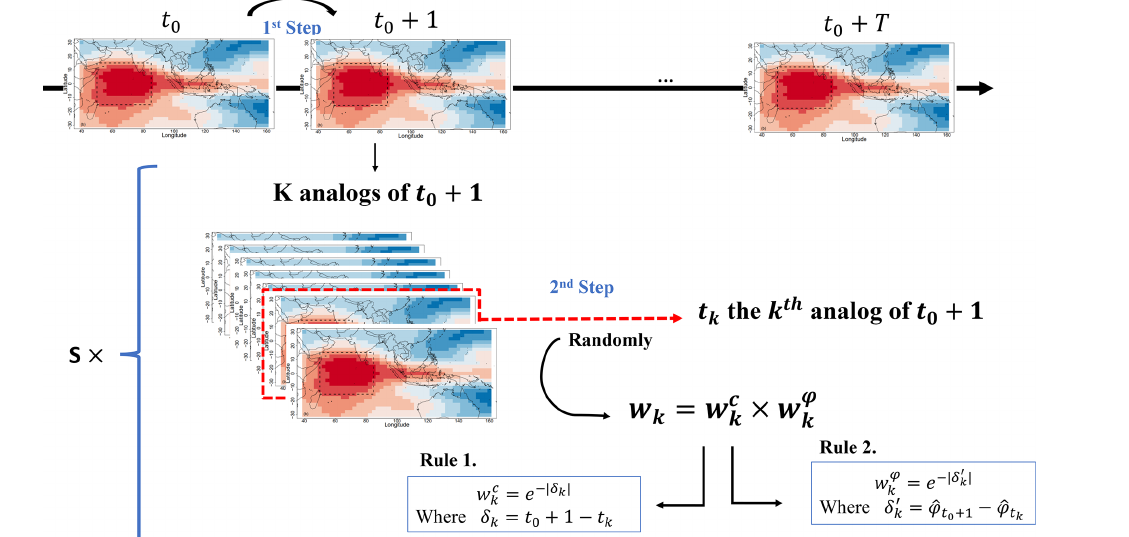
Figure 3. Illustration of the SWG process. The first step goes from a given day to the next day. The second step explains how we randomly select a k th analog with respect to weight w k